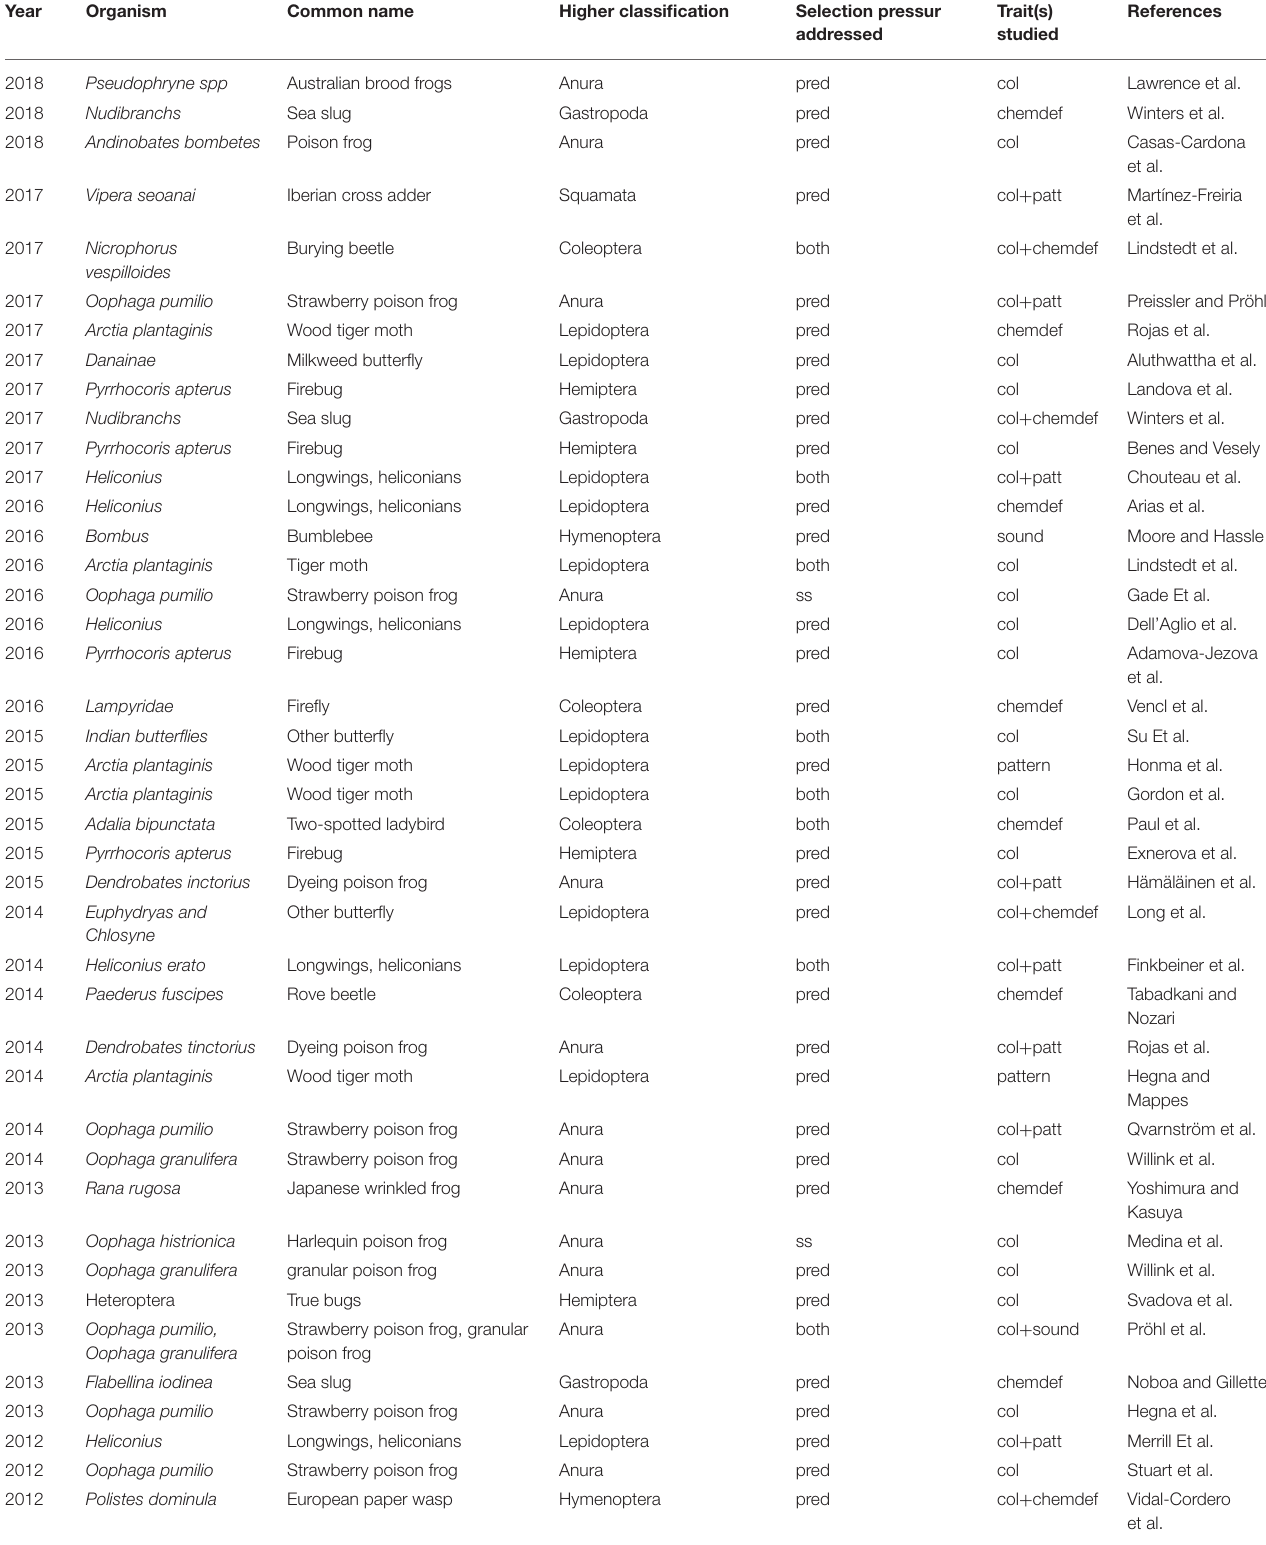
TABLE 1 | Studies included in the review of literature published on aposematism over the last three